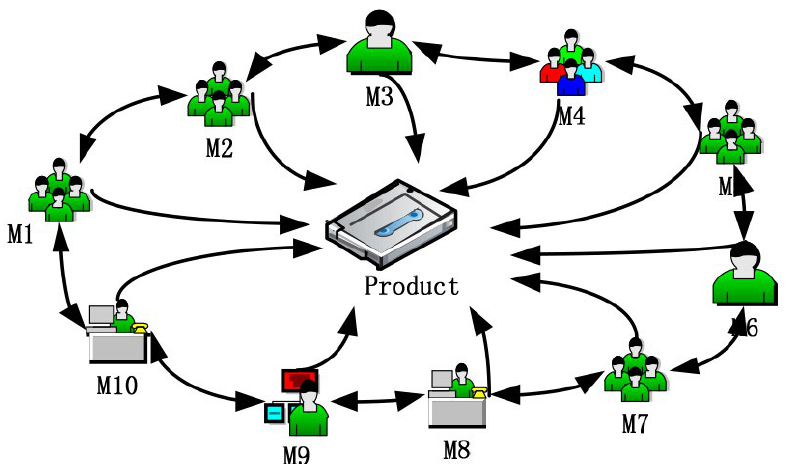
Figure 4. 10 design agents of the Duff